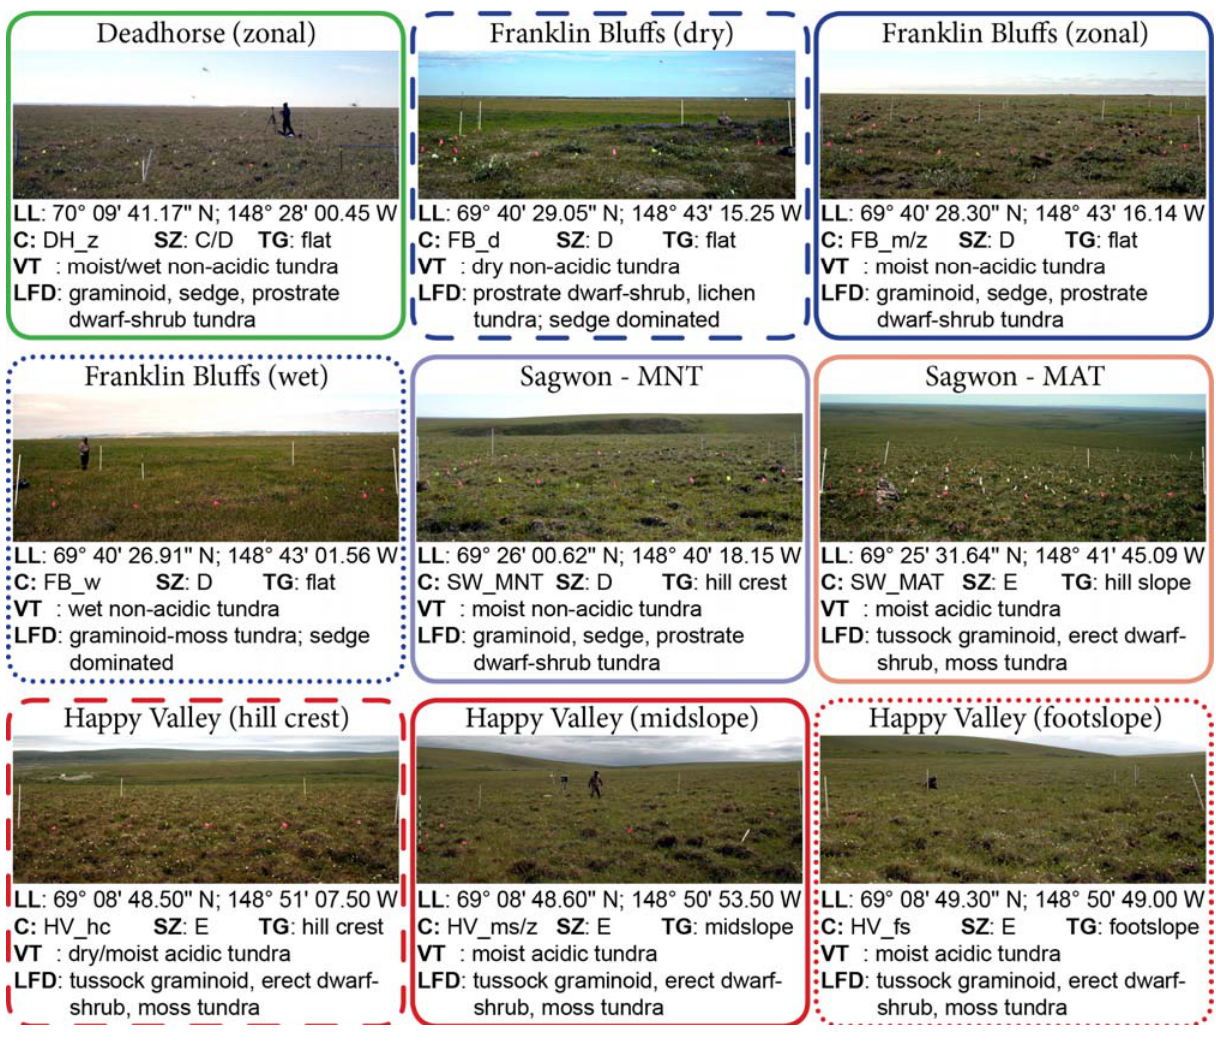
Figure 3. Study sites along the NAAT and the main site characteristics [54,55].